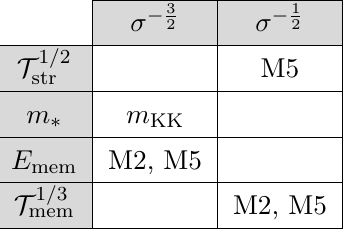
Table 13 . Mass scalings along the flows generated by the string with charges (1 , 1 , 1 , 0 , 0 , 0 , 0) . e = (1 , 1 , 0 , 0 , 0 , 0 , 0) A non-elementary string with only non-null charges e 1 = e 2 = 1 induces the flow s 1 ∼ s 2 ∼ σ → ∞ , while the other saxions remain fixed. The tower scale m is set by lightest KK modes, associated to R ∗